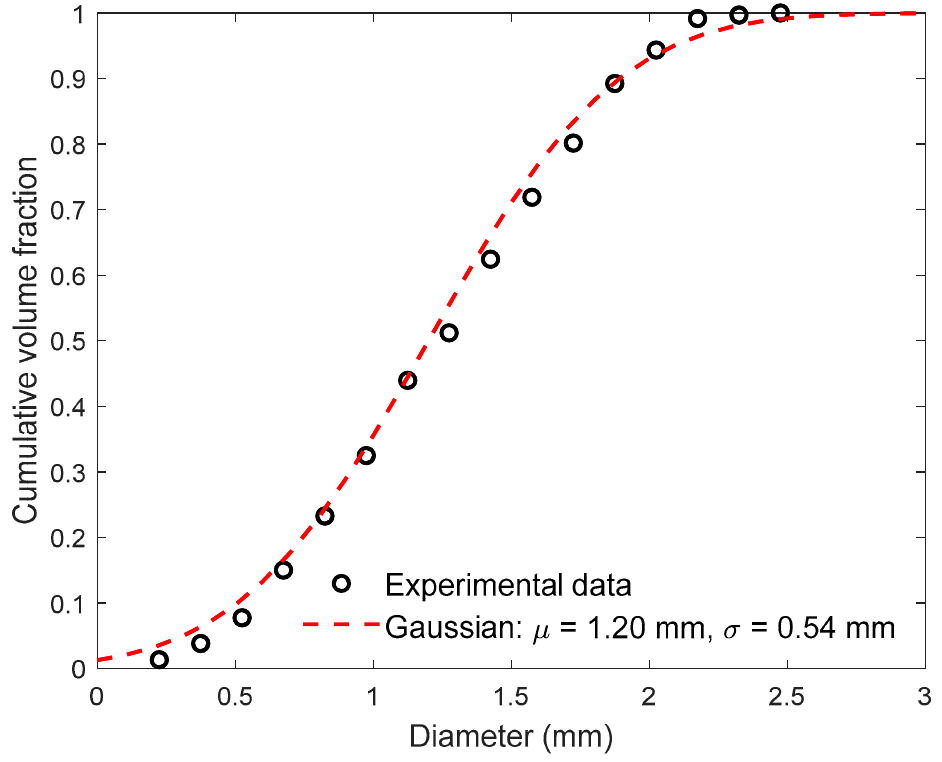
Figure A3. The cumulative volume fraction of oil droplets from the experiment and those approximated